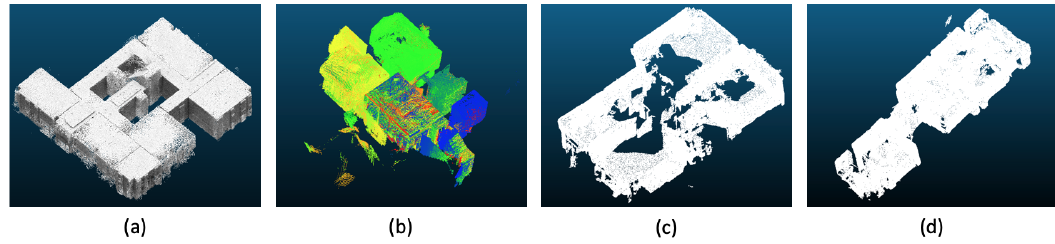
Figure 4. Input 3D point clouds: ( a ) seventh floor of the Robot Convergence Building at Korea University, ( b ) second floor of residential house , ( c ) Tango Scan-1 and ( d ) Tango